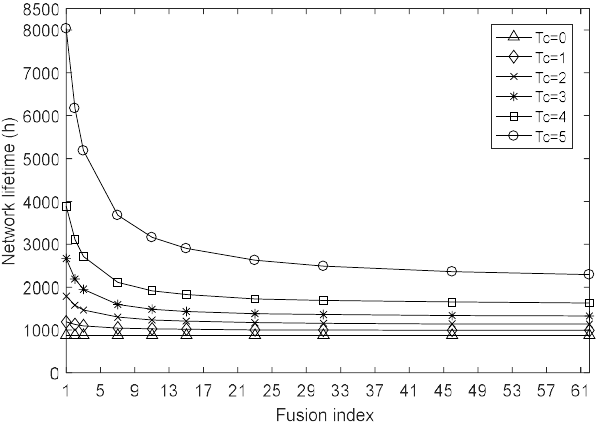
Sensors 2018 , 18 , x FOR PEER REVIEW Figure 2. Network lifetime with varying fusion index. Figure 2. Network lifetime with varying fusion index. Figure 3. Average hops with varying fusion index.